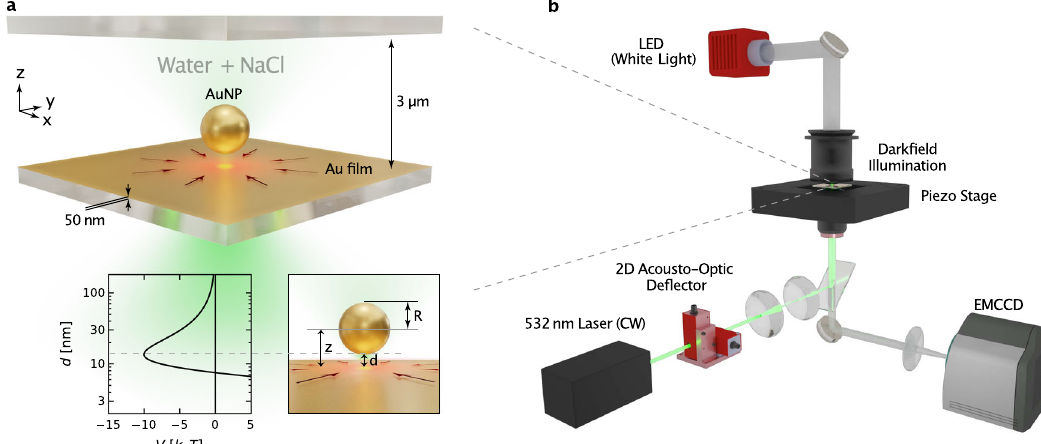
Fig. 1 Thermo-hydrodynamic manipulation of AuNPs in NaCl solution. a The sample consists of two glass slides that con fi ne a 3 μ m thin liquid fi lm of gold nanoparticles (AuNPs) with radius R dispersed in aqueous NaCl solution. The lower glass slide carries a 50 nm Au fi lm that is locally heated by optical absorption of a focused laser of λ = 532 nm wavelength. The inset depicts the DLVO (Derjaguin, Landau, Verwey, Overbeek) potential as described in the main text and Supplementary Notes 4 for a R = 125 nm AuNP in 10 mM NaCl. b The experimental setup comprises an inverted optical microscope equipped with a steerable focused laser of λ = 532 nm wavelength controlled by an acusto-optic de fl ector. The AuNPs are observed using dark fi eld illumination with an oil-immersion dark fi eld condenser (NA 1.2) and a ×100 oil-immersion objective set to NA 0.6. Images are recorded with an EMCCD camera, typically, with an inverse framerate of τ = 20 ms.